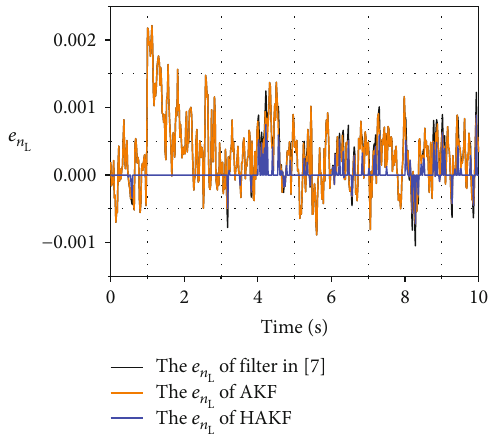
Figure 12: The estimated error e